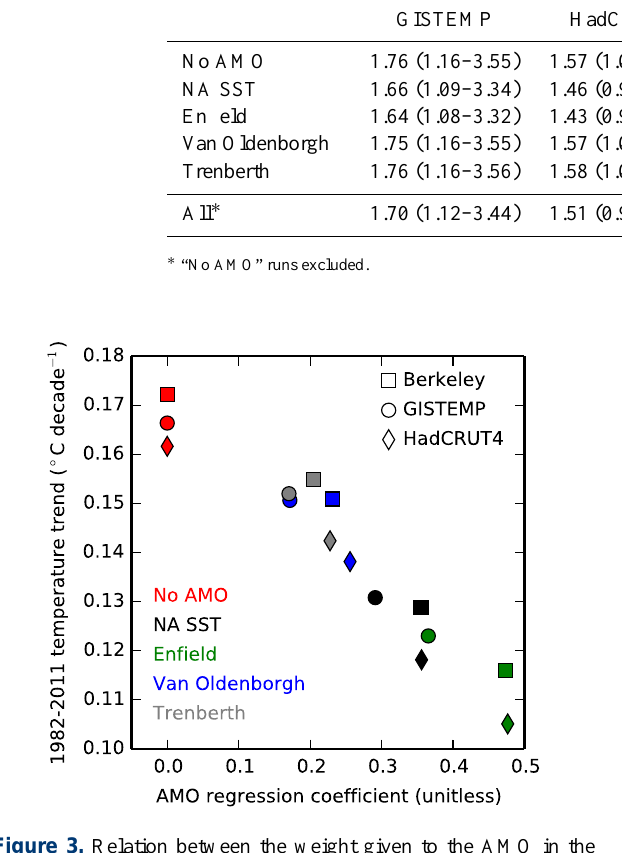
Figure 3. Relation between the weight given to the AMO in the MLR and the derived anthropogenic temperature trend over 1982– 2011 for three different temperature data sets and five different AMO characterizations.